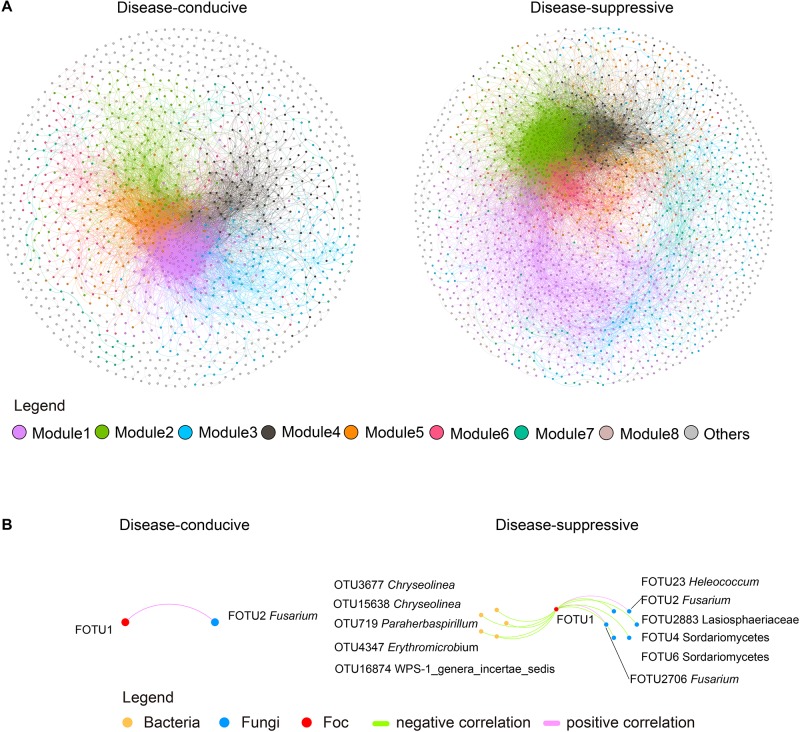
Co-occurrence networks of disease-conducive and -suppressive soils with F. oxysporum f. sp. cubense (Foc) invasion. (A) Network constructed with strong (SparCC’s | r| > 0.8) and significant (P < 0.01) correlations. Nodes represent different OTUs and are colored by modularity class (fast unfolding) in gephi. Gray color refers to modules with less than 50 nodes. (B) OTUs related to Foc OTUs in the co-occurrence network. Each node refers to a unique OTU. Orange, blue, and red represent bacteria, fungi and Foc, respectively. Green and pink edges refer to significant (P < 0.01) negative and positive correlations between nodes.